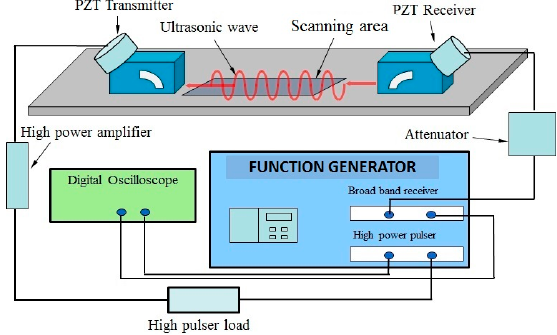
Figure 5. Ultrasonic measurement system.